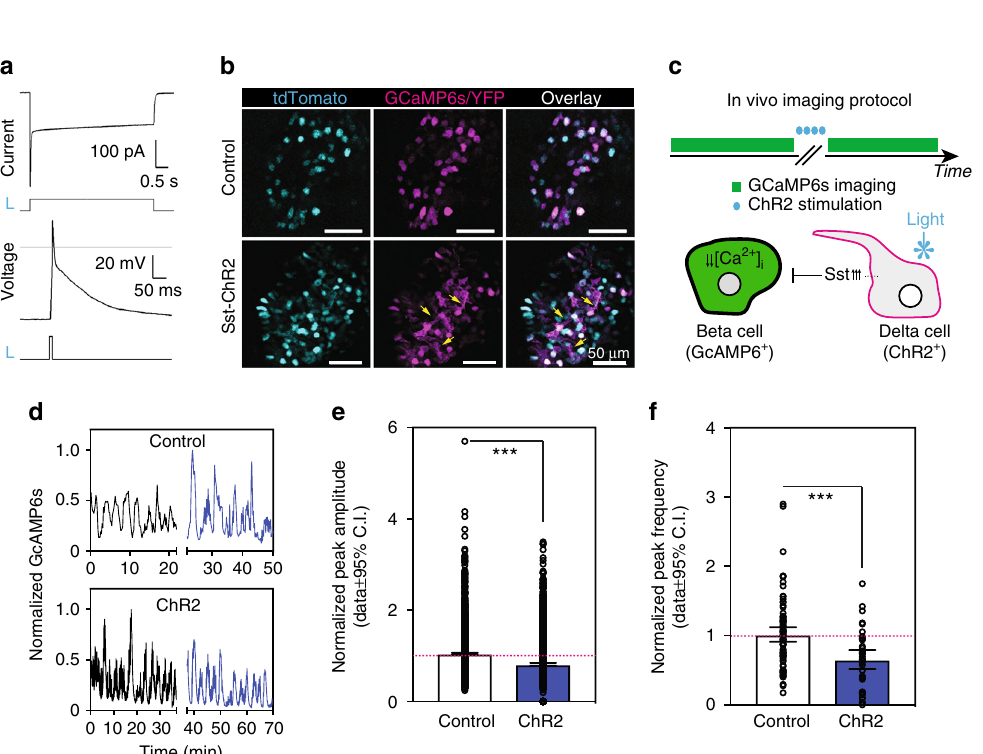
Fig. 4 Optogenetic control of delta cell activity. Somatostatin reduces beta cell [Ca 2 + ] i oscillatory frequency and peak amplitude, and hyperglycemia is associated with impaired delta cell function and longer fi lopodia. a Photostimulation of delta cells expressing ChR2 evoked inward photocurrents under voltage clamp conditions (top; holding potential = − 70 mV) and light-evoked, overshooting action potential-like responses under current-clamp conditions (bottom). Timing of light fl ashes (470 nm) is indicated by lower traces (L). Dashed line = 0 mV. b tdTomato and GCaMP6s/YFP fl uorescence signal in wild-type and SST-ChR2 islets. c Top, protocol for in vivo imaging and ChR2-mediated photostimulation (450 – 470 nm light). Bottom, cartoon illustration representing the experimental setup and expected biological responses of GCaMP6 + beta cells and ChR2 + delta cells. d Representative beta cell [Ca 2 + ] i traces in islets from wild-type (top) or SST-ChR2 mice (bottom). e Normalized beta cell [Ca 2 + ] i peak amplitude and f peak frequency in wild-type ( n = 7 islets) and SST-ChR2 islets ( n = 5 islets) before and after ChR2 stimulation in vivo. e *** p < 0.001 by two-tailed student t -test and in f , *** p = 0.001 vs light-stimulated WT islets. In e , f data are displayed as fold change from nonstimulated conditions, represented by the horizontal pink dotted lines. Error bars represent the 95% con fi dence interval (C.I.) of the mean. For e , f source data are provided as a Source Data fi